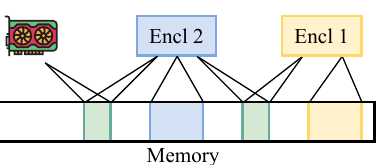
Figure 2: Example of private and shared memory regions with two enclaves, and a peripheral. Note that the shared memory region between the peripheral and Encl 2 can either be MMIO registers, and thus not backed by actual DRAM, or a DMA